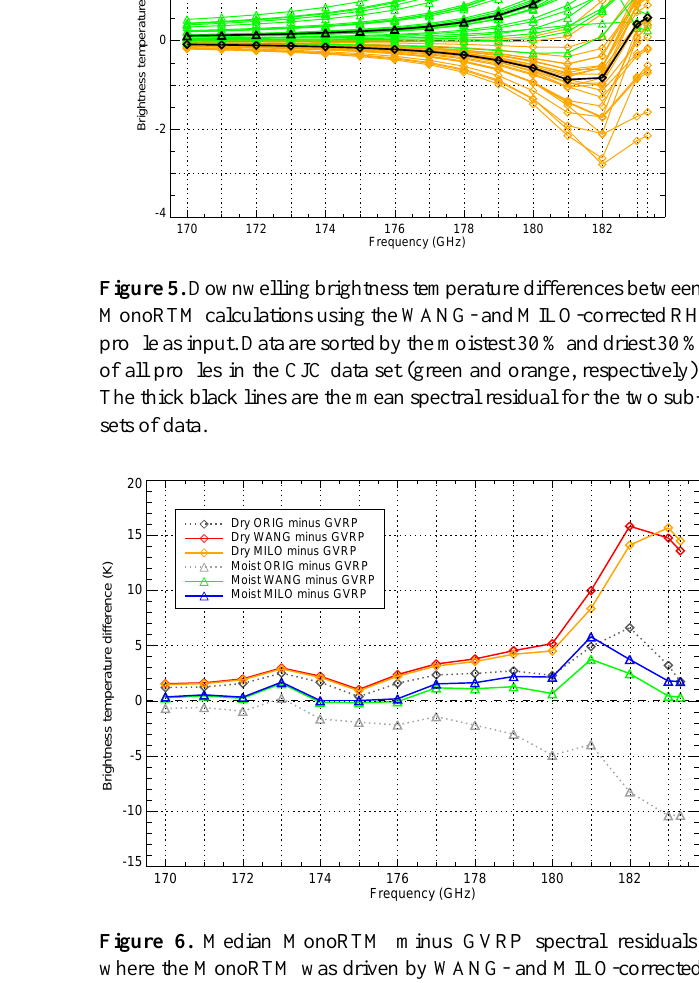
tween the GVRP and MonoRTM-computed T B at 183.0 and (Table 2), suggesting that neither algorithm adds skill at the very low PWV amounts seen in this category of cases. Given CJC site (Fig. 7), the precision of the RH measurement it- self (0.5 %) propagates an additional error as high as 0.5 % in the resultant WANG/MILO corrections at the CJC site (re- sult not shown). This adds an additional residual error to the otherwise bias-corrected MonoRTM-computed T B